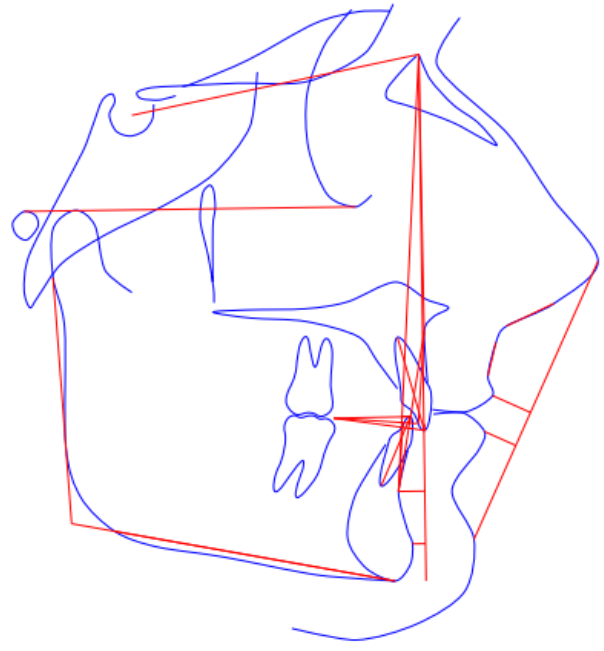
Figure 14. Post-treatment cephalometric tracing. Table 2. Post-treatment cephalometric values of case number 1.